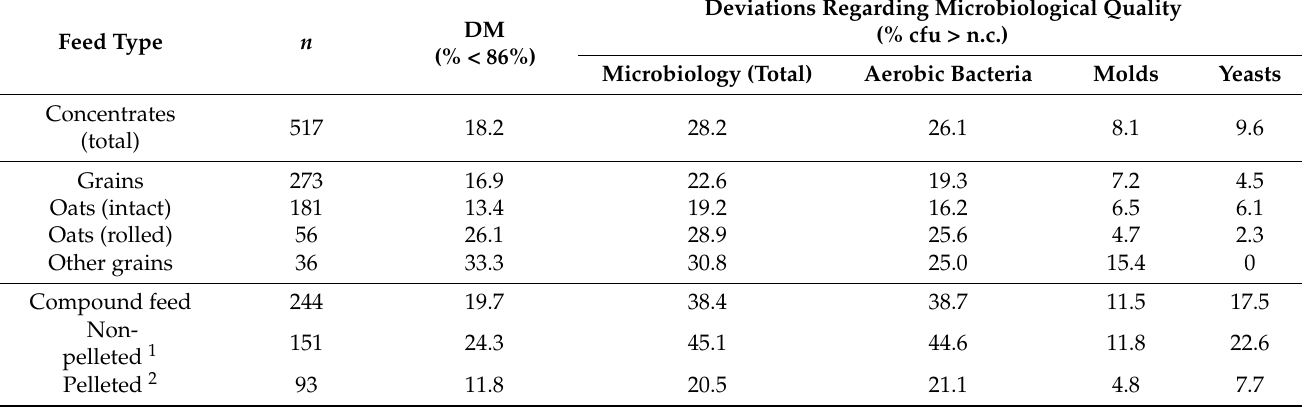
Table 3. Proportional frequency of deviations in hygienic quality regarding dry matter content (DM) and microbiological quality (assessed using VDLUFA orientation values [14] ).